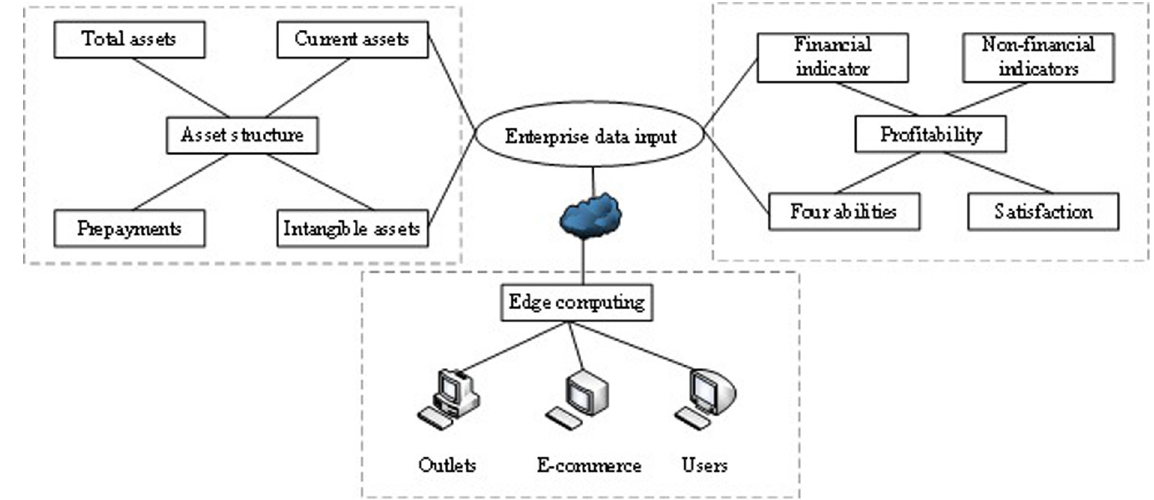
Fig 1. The enterprise analysis model based on cloud computing and strategic management